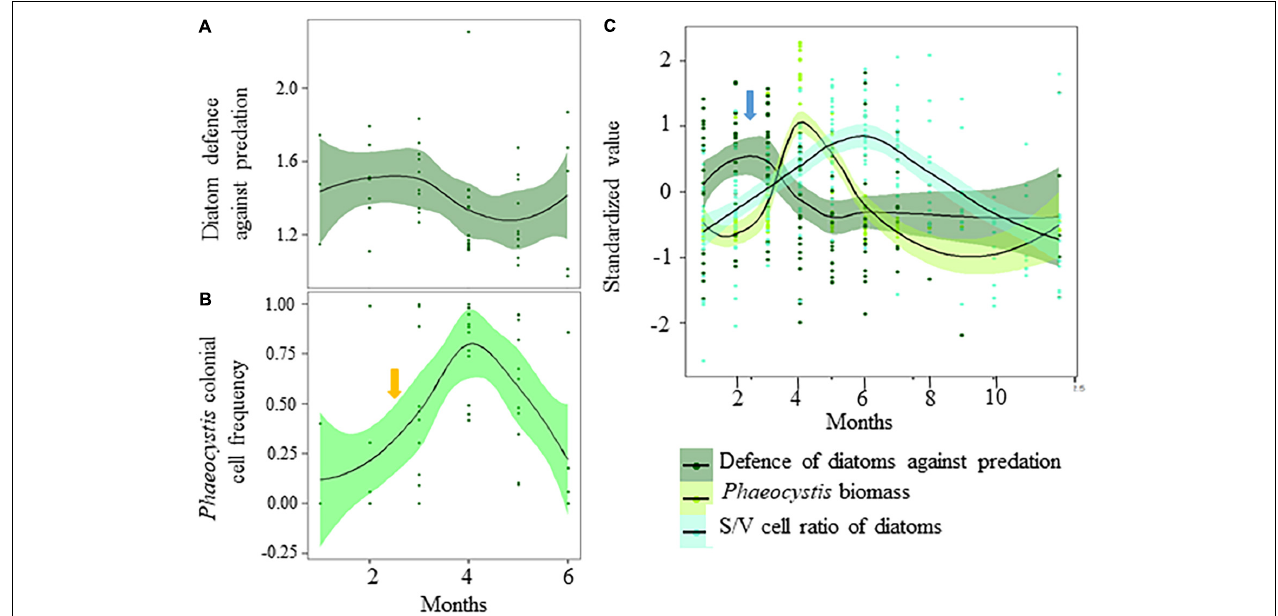
FIGURE 8 | Winter-spring variations in panel (A) the Community-Weight mean of Defence against predation of the diatom community (standardized value; black line and dark green shading), and (B,C) Phaeocystis colonial cell frequency and biomass (standardized value; black line and green shading) in coastal waters of the eastern English Channel over the (A,B) 2007–2019 and (C) 1996–2019. The solid line and ribbon represent LOESS smoothing and the 95% confidence interval, respectively. Standardized values were calculated per year. Note that (A) the seasonal maximum of the defense trait value, (B) the start of the transformation of Phaeocystis flagellate cells into colonial cells embedded into a mucopolysaccharide matrix (orange arrow) and (C) the start Phaeocystis bloom timing (blue arrow) are synchronised. Note that the S/V cell ratio of diatoms as proxy of competitiveness is low at this time (C)